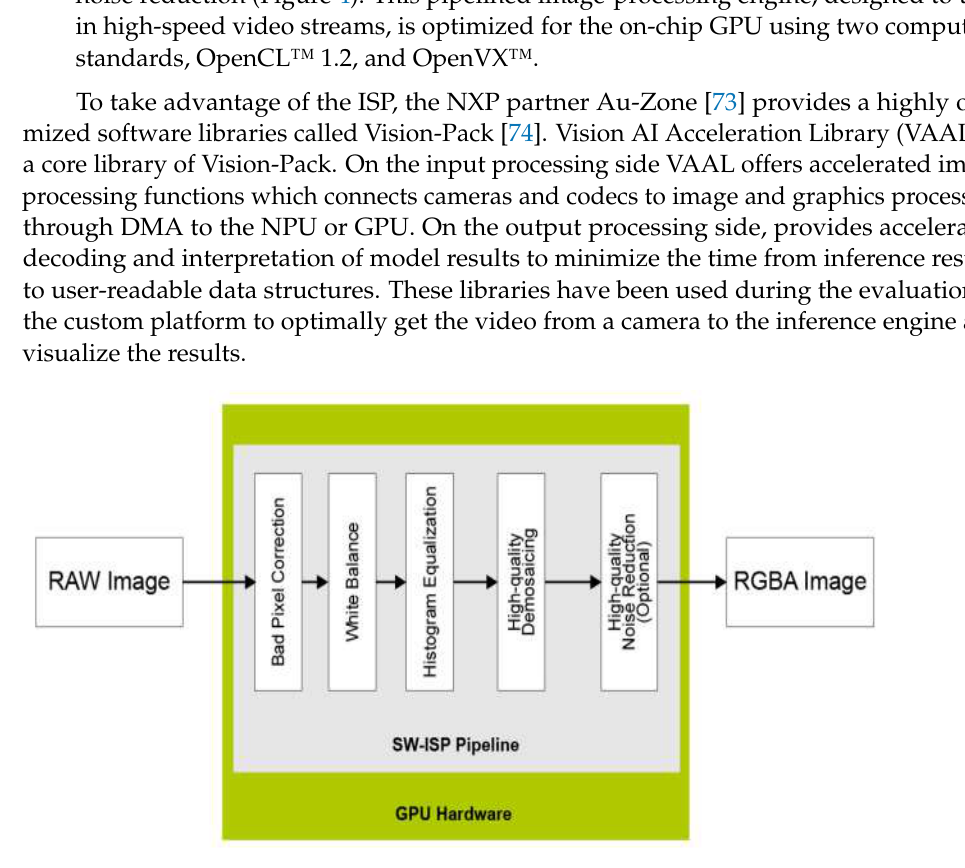
Figure 4. NXP Image Signal Processing Software (optimized by OpenCL 1.2 and OpenVX 1.1) [75].